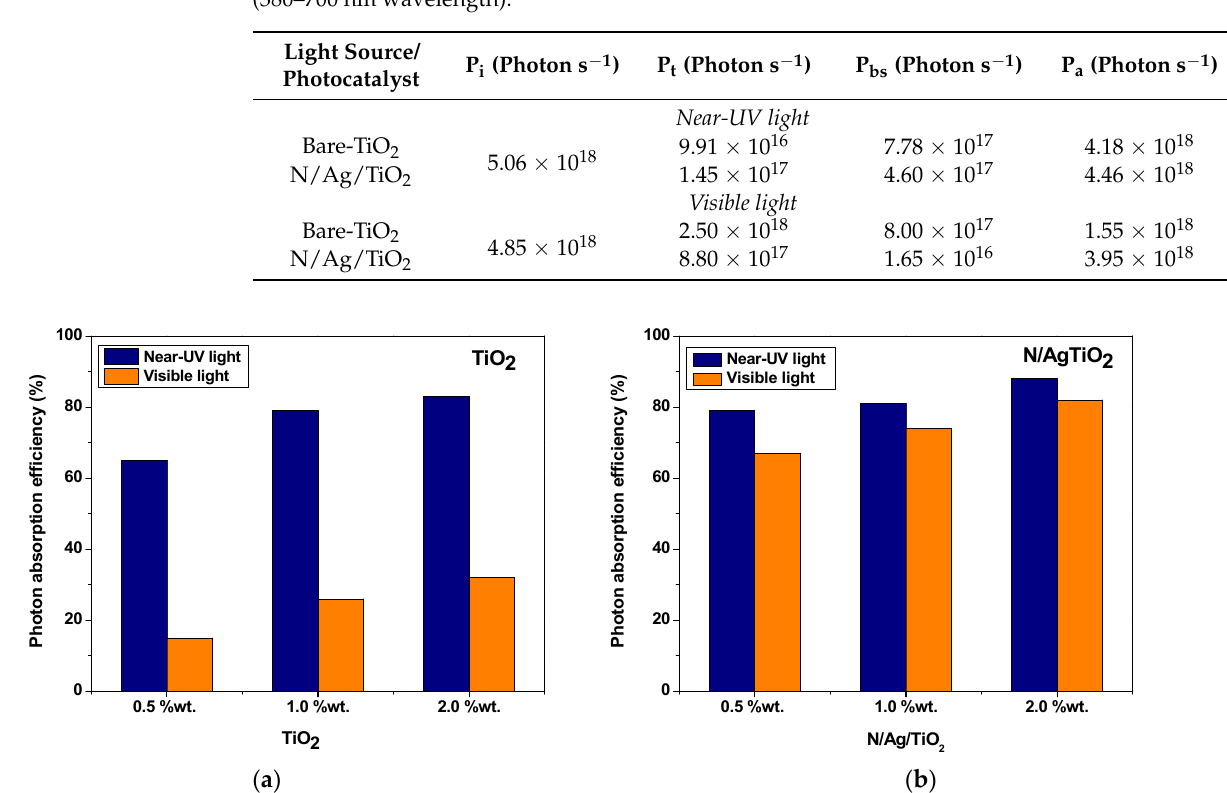
Figure 4. Near-UV light and visible light radiation photon absorption efficiencies on: ( a ) bare-TiO 2 , and ( b ) N/Ag/TiO 2 . Both bare-TiO 2 and N/Ag/TiO 2 are coated on the cylindrical stainless-steel woven mesh at different particle loadings (0.5–2 wt.%).